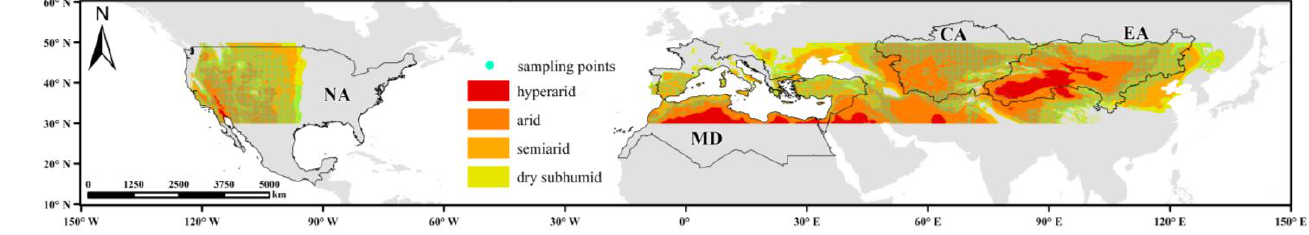
Figure A2. Distributions of the sampling points.